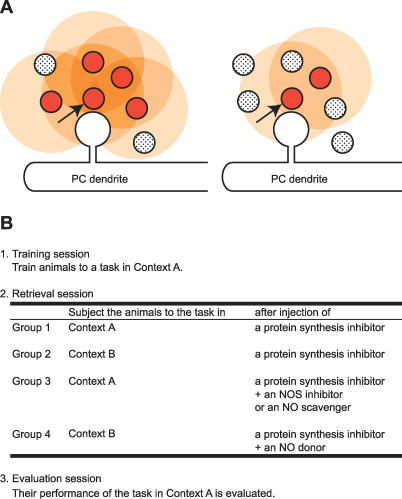
A Novel Hypothesis of the Cellular Mechanism for Context-Dependent Cerebellar Learning and an Experiment to Test It(A) Schematically shown are a PF–PC synapse and its surrounding PFs in a parasagittal section of the cerebellar cortex. Firing PFs are indicated by red solid circles, and those at rest are indicated by gray dotted circles (note that their beams are perpendicular to the sagittal plane.) Some neighboring PFs might fire together with the PF making the synapse (arrow) and produce NO (orange semitransparent circles); others might not. Left: when a few PFs in the neighborhood fire together, that will result in a sufficient concentration of NO for the PF–PC synapse to be modified. Right: when only a small number of PFs fire together, [NO] will not increase to the level necessary for the synapse to be modified.(B) The experimental protocol.